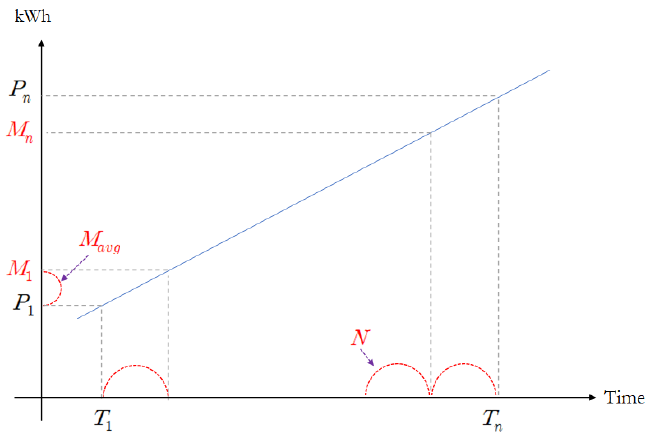
Figure 2. Calculation method of linear interpolation.